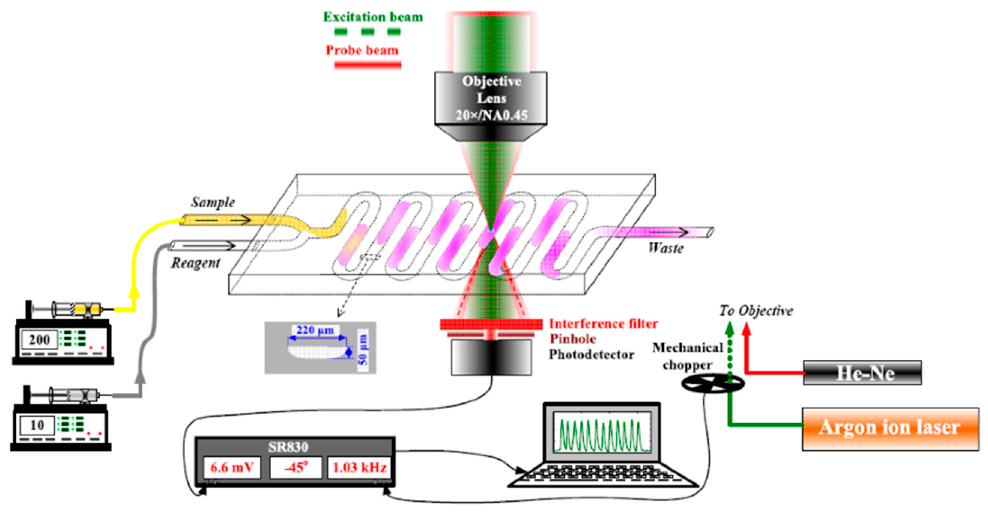
Figure 3. Schematic presentation of a µFIA − TLM detection platform for determination of microcys- tin − LR.